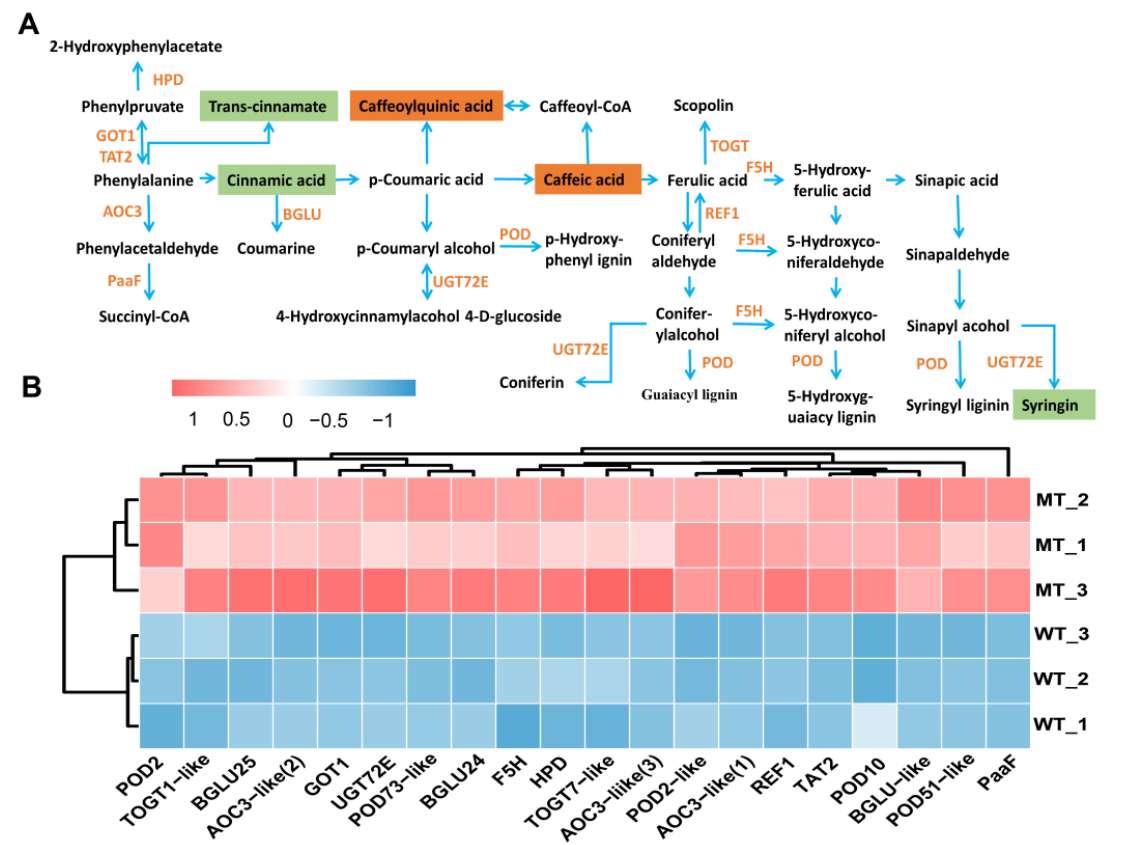
Figure 11. Phenylalanine metabolism and phenylpropanoid biosynthesis pathway ( A ) and relative expression level of DEGs ( B ). POD, peroxidase; F5H, cytochrome P450 84A1; BGLU, beta-glucosidase; REF1, aldehyde dehydrogenase; UGT72E, anthocyanidin 3-O-glucosyltransferase; TOGT1-like, scopoletin glucosyltransferase1-like; TOGT7-like, UDP-glucose flavonoid 3-O-glucosyltransferase 7-like; TAT2, probable aminotransferase; AOC3-like, primary amine oxidase-like; GOT1, aspartate aminotransferase; PaaF, probable enoyl-CoA hydratase; HPD, 4-hydroxyphenylpyruvate dioxygenase. The analyses used WT as a control.